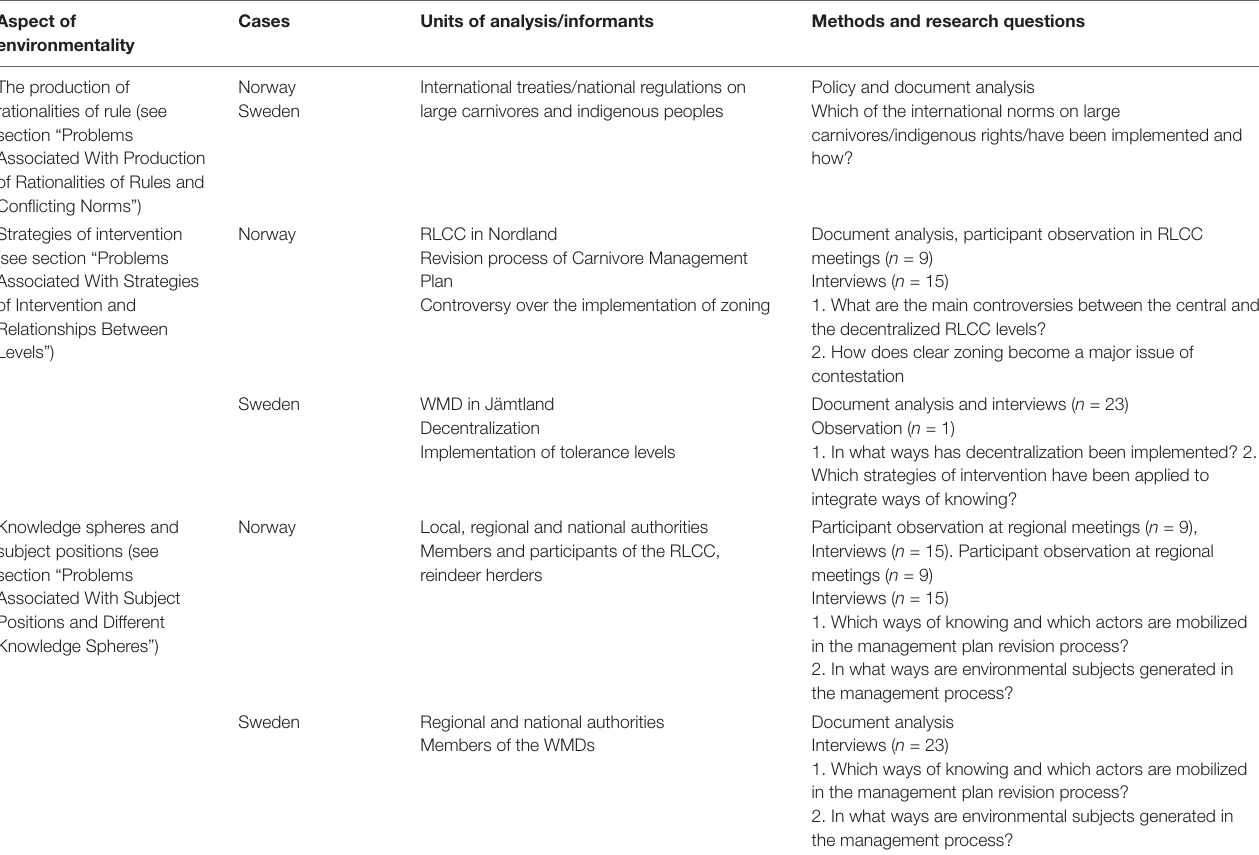
TABLE 1 | Analytical dimensions, units of analysis, methods, and research questions. Aspect of